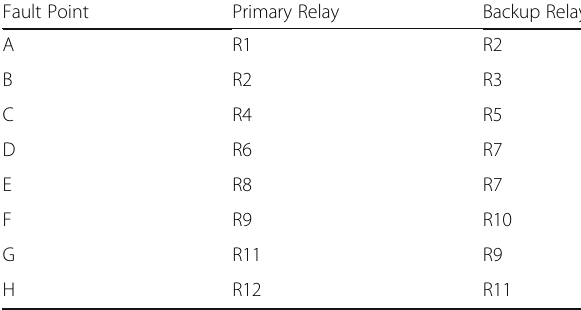
Table 1 Primary and Backup Relay